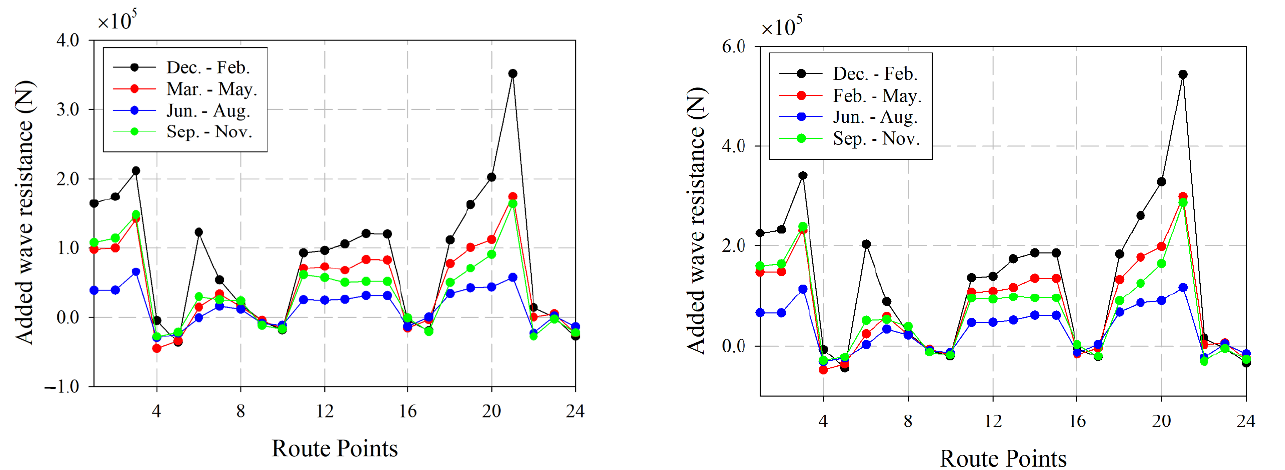
Figure 10. Added wave resistance in irregular waves for two load conditions for Froude number equal to 0.24. ( Left ) Load Condition 1. ( Right ) Load Condition 2. Source: Own elaboration